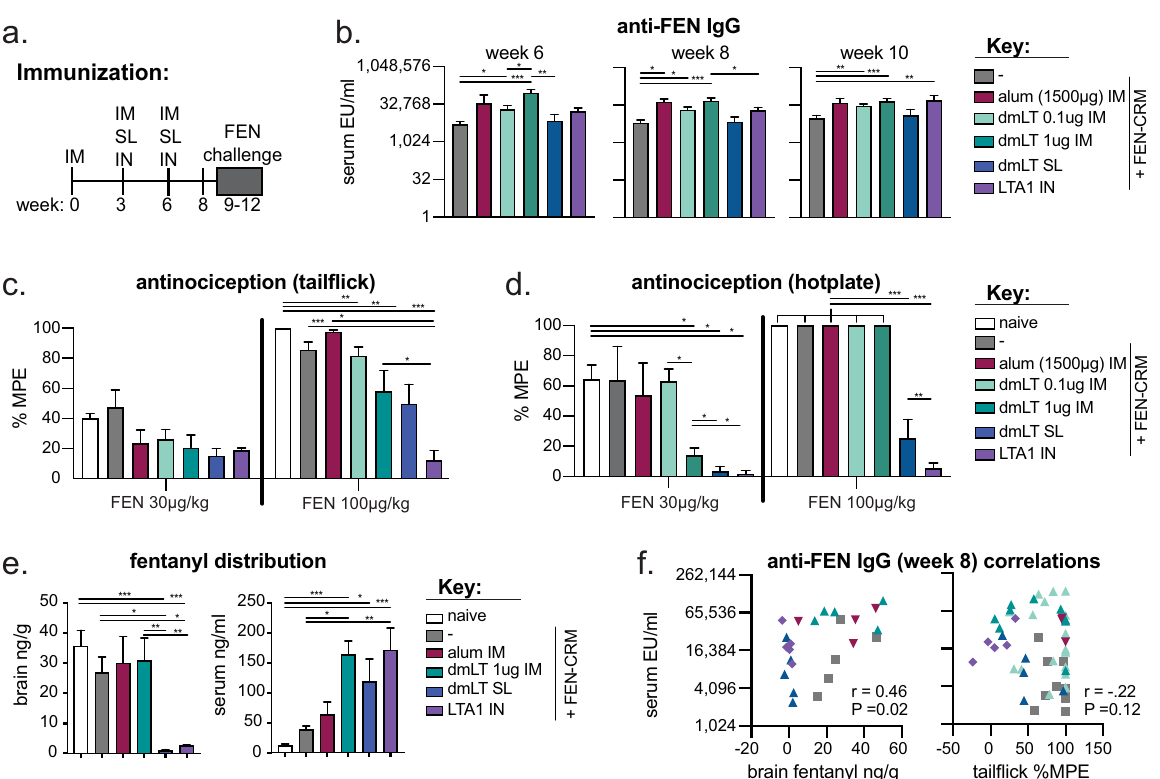
Fig. 6 Reduction in fentanyl-induced antinociception and brain tissue distribution in dmLT and LTA1 vaccinated animals compared to alum or antigen alone groups. Groups of Balb/c mice ( n = 5 – 20) were left naïve or immunized on weeks 0, 3, and 6 with FEN-CRM IM or with adjuvant and route combinations as performed previously. These included 1500 μ g alum IM, 0.1 – 1 μ g dmLT IM, 0.1 μ g dmLT IM + 5 μ g dmLT SL boosters (dmLT SL), or 5 μ g LTA1 IM + 5 μ g LTA1 IN boosters (LTA1 IN). FEN-CRM was administered at 5 μ g for IM delivery and 9 – 10 μ g for mucosal delivery. Blood was collected on week 6, 8, and 10 for serum analyses and mice challenged with fentanyl doses during weeks 9 – 12. Nociception tests were conducted using tail fl ick and hotplate assays with tissue taken for drug quanti fi cation. a Schematic of immunization schedule. b Compiled serum anti-FEN (FEN-BSA) serum IgG ELISA from week 6, 8, and 10 tailbleeds. c % maximum possible effect (MPE) from tail fl ick antinociception evaluation. d % MPE from hotplate antinociception evaluation. e Fentanyl concentrations in brain and serum after a fi nal 0.1 mg/kg fentanyl challenge. F Correlation between brain fentanyl levels or tail fl ick antinociception %MPE vs anti-FEN serum IgG for immunized groups. Bars at mean + s.e.m. with signi fi cance determined by ANOVA paired with Bonferroni post-hoc test as shown (* P < 0.05, ** P < 0.01, *** P < 0.001). Spearman correlations P values and correlation coef fi cient ( r ) indicated on relevant